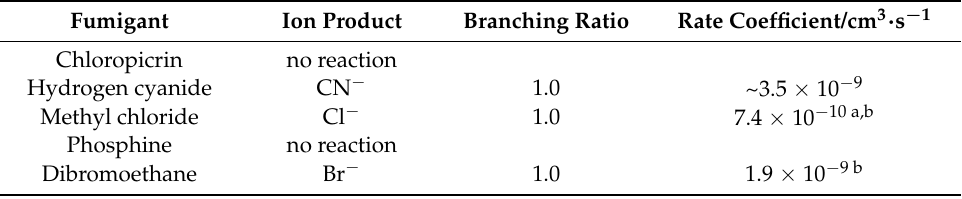
Table 3. O 2 − reactions of fumigants in nitrogen carrier gas and flow tube at 120 ◦ C.